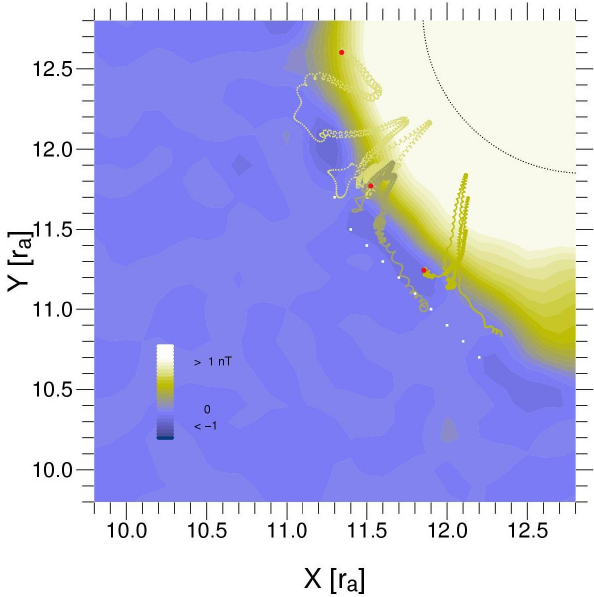
Fig. 3. Distribution of the Z-component of the magnetic induction in (x, y) plane, near the object and its magnetopause. Parts of three electron trajectories are overplotted, commencing with red points, and the wave duct is represented by the train of ten white